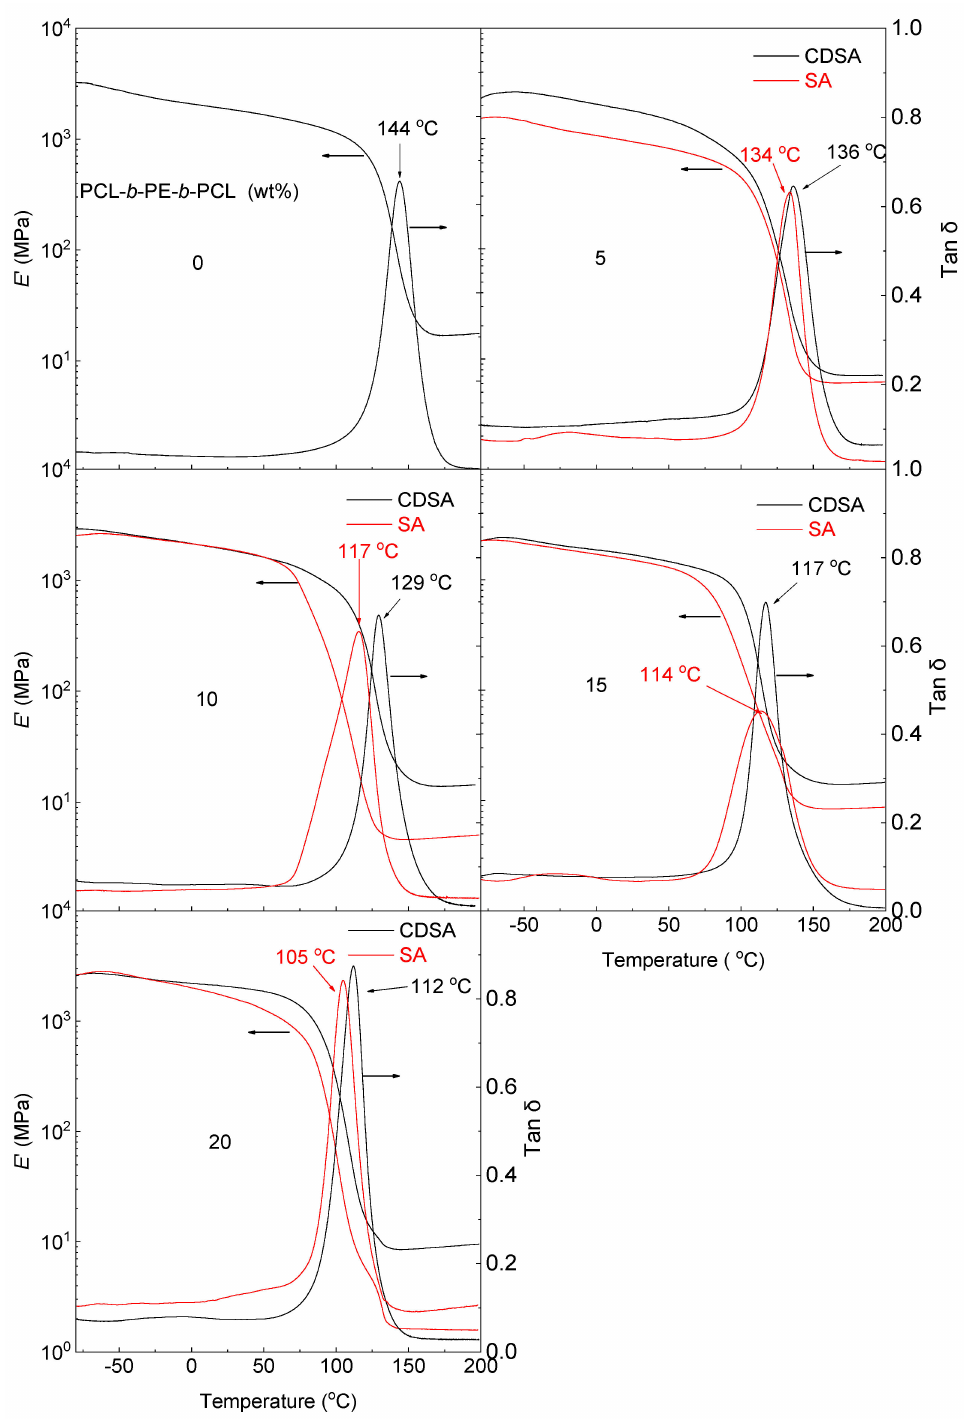
Figure 9. DMTA curves of epoxy thermosets containing 0, 5, 10, 15 and 20 wt% of PCL -b- PE -b- PCL via SA and